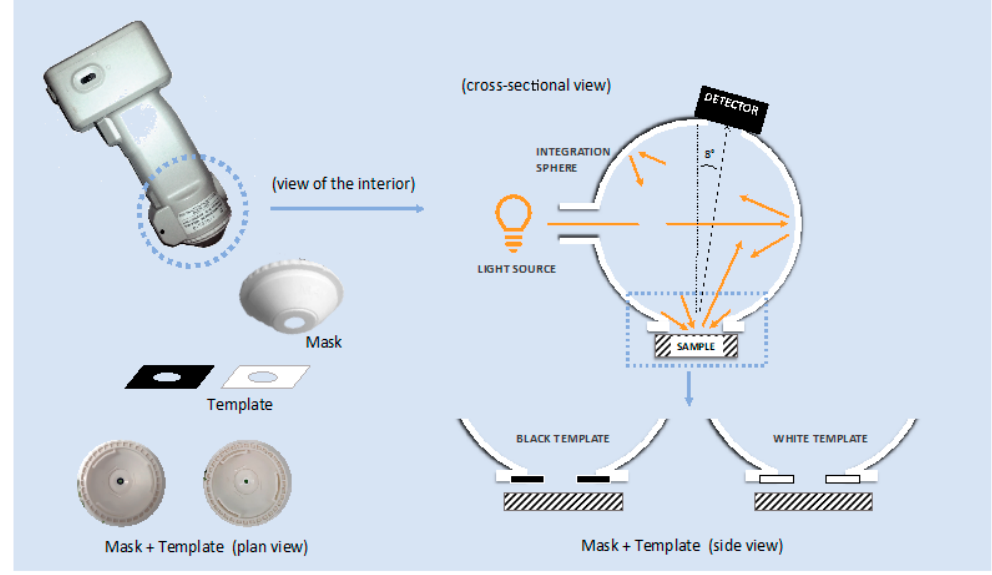
Figure 3. Schematic diagram showing the custom-designed set up for color measurement provided by, the portable spectrophotometer. The template partially plugs the sample port that becomes 50% or 70% smaller and, in turn, expanding the sphere